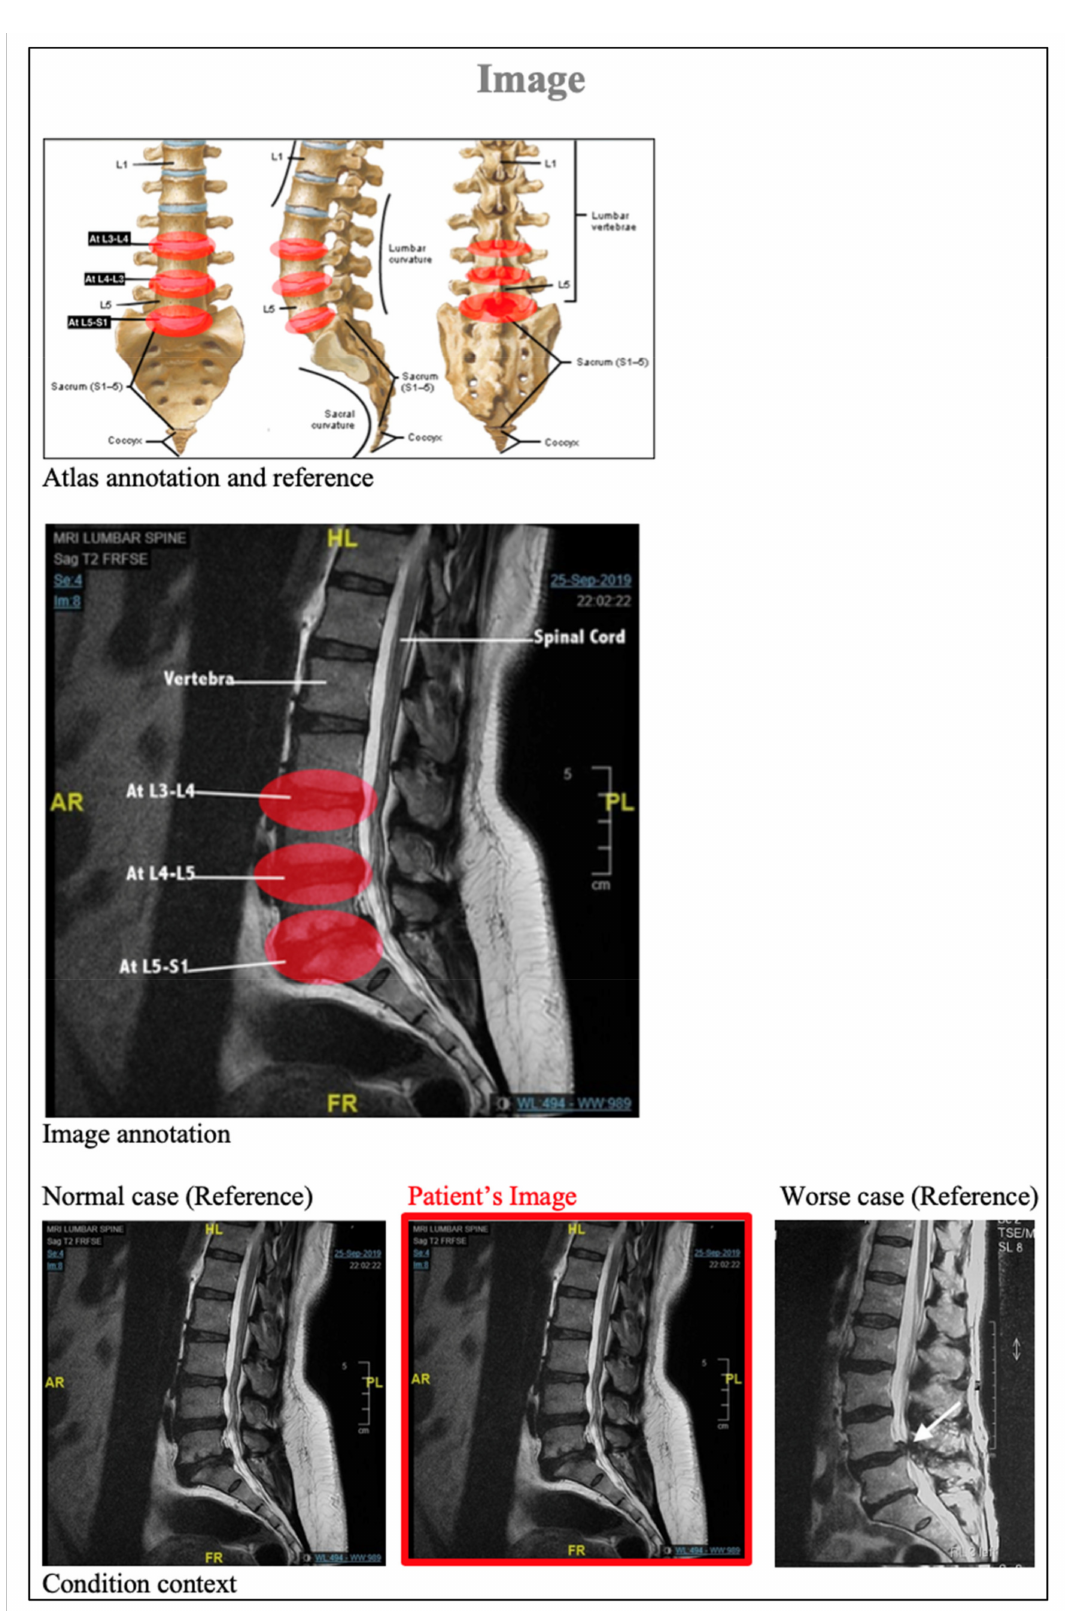
Figure 3. Revised design of the MRI lumbar spine